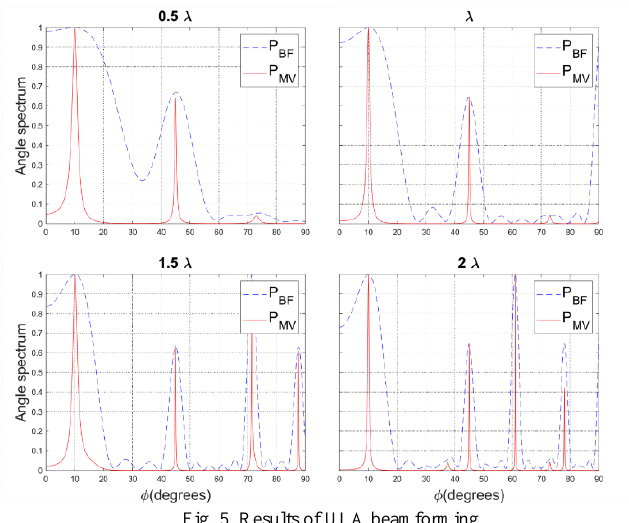
Fig. 5. Results of ULA beamforming